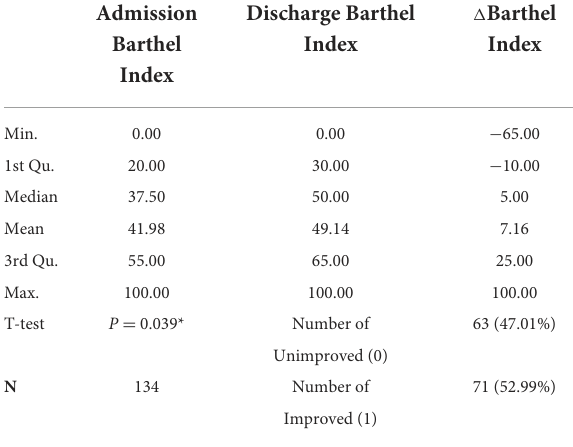
TABLE 2A Comparison of Barthel Index before and after